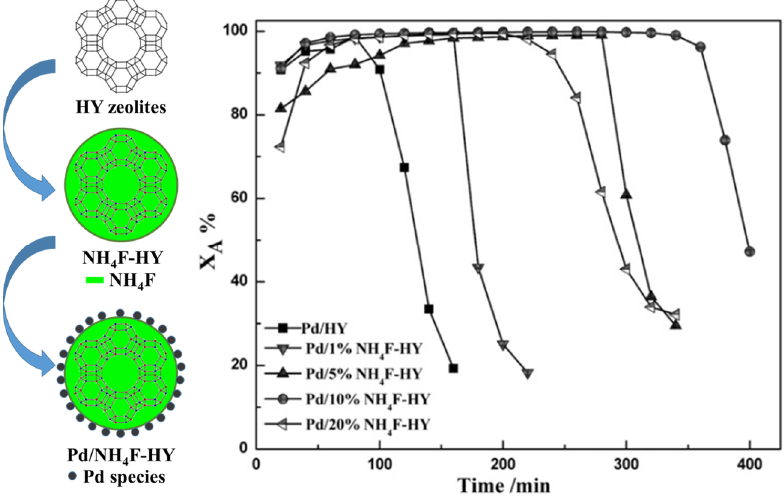
Figure 14. Pd/HY catalysts modified with NH 4 F for acetylene hydrochlorination. Adopted from Ref [101].